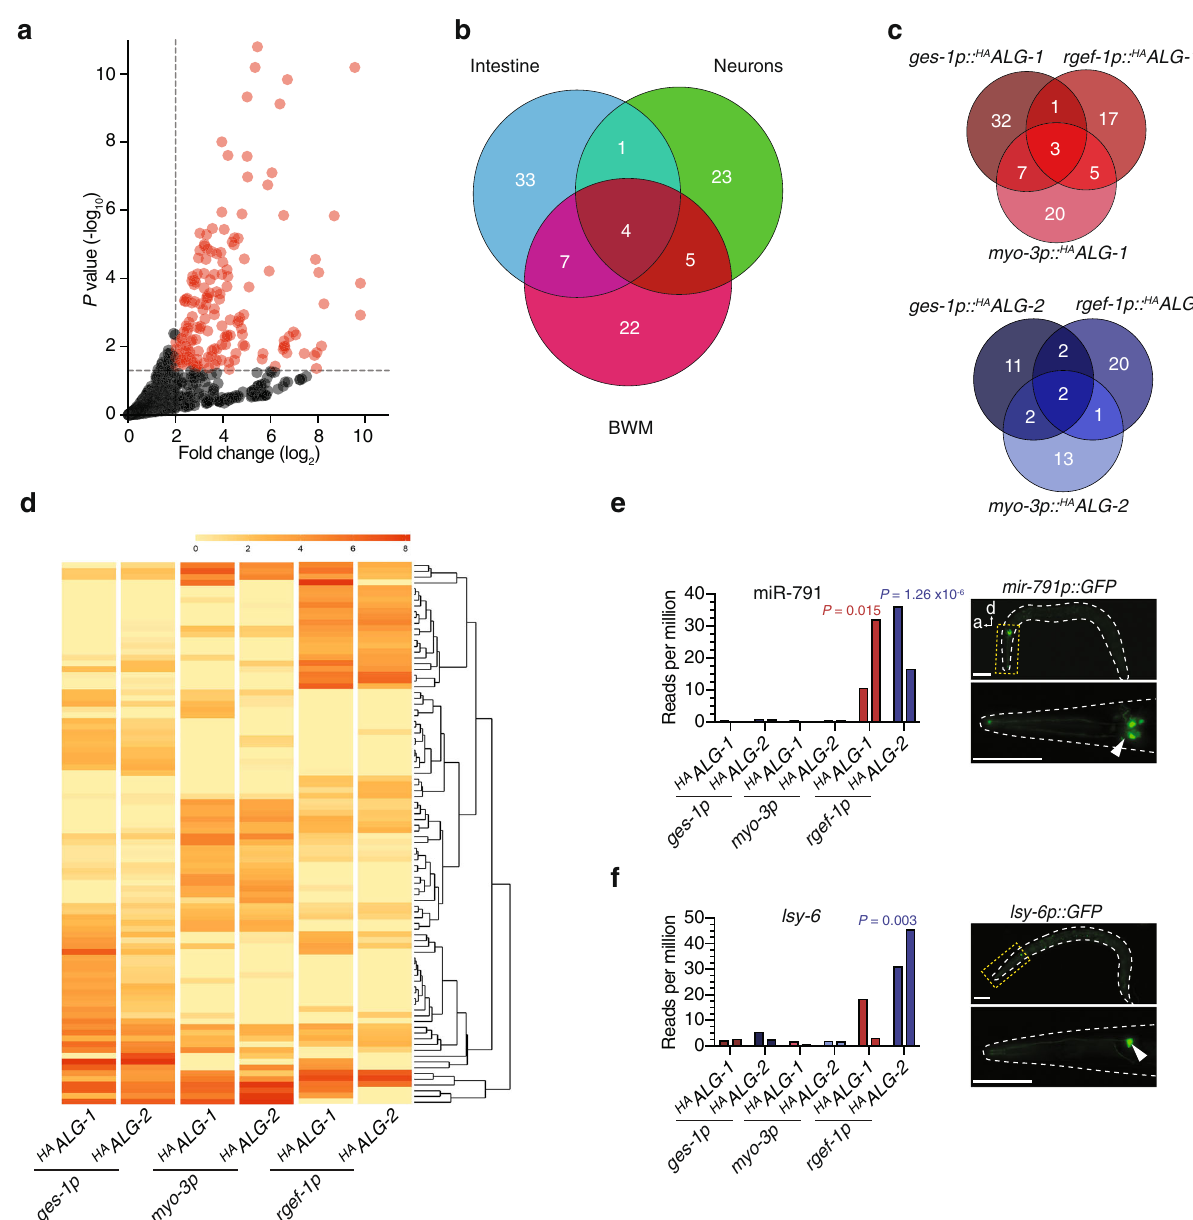
Fig. 2 Genome-wide pro fi ling of cell-type- and AGO-speci fi c miRNAs. a Volcano plot showing all reference miRNAs enriched (log 2 fold change > 2, P < 0.05 relative to wild type) in immunoprecipitations of HA ALG-1 or HA ALG-2 in one or more cell-type (red). P value was calculated by fi tting a two-tailed negative binomial model to processed read counts, according to edgeR pipeline for pairwise comparisons between multiple groups. b Venn diagram representation of all AGO-loaded (either ALG-1 or ALG-2) cell-type-speci fi c miRNAs in intestine (blue), neurons (green) or body wall muscles (BWM, pink). c Venn-diagram depicting cell-type-speci fi c and AGO-type-speci fi c loading of miRNAs (ALG-1 — top and ALG-2 — bottom). d Heatmap showing unsupervised clustering of ALG-1 or ALG-2 cell-type-speci fi c loading of miRNAs. e Sensitivity of cell-type-speci fi c immunoprecipitation demonstrated by detection of miR-791 expressed from three neurons (right — fl uorescence image of miR-791p::GFP ). Scale bars, 50 µ m. f Enhanced sensitivity of cell-type- speci fi c immunoprecipitation demonstrated by detection of lsy-6 expressed from a single neuron (right — fl uorescence image of lsy-6p::GFP ). e , f Graph shows reads per million in indicated cell types of two biological replicate experiments, two bars. Scale bars, 50 µ